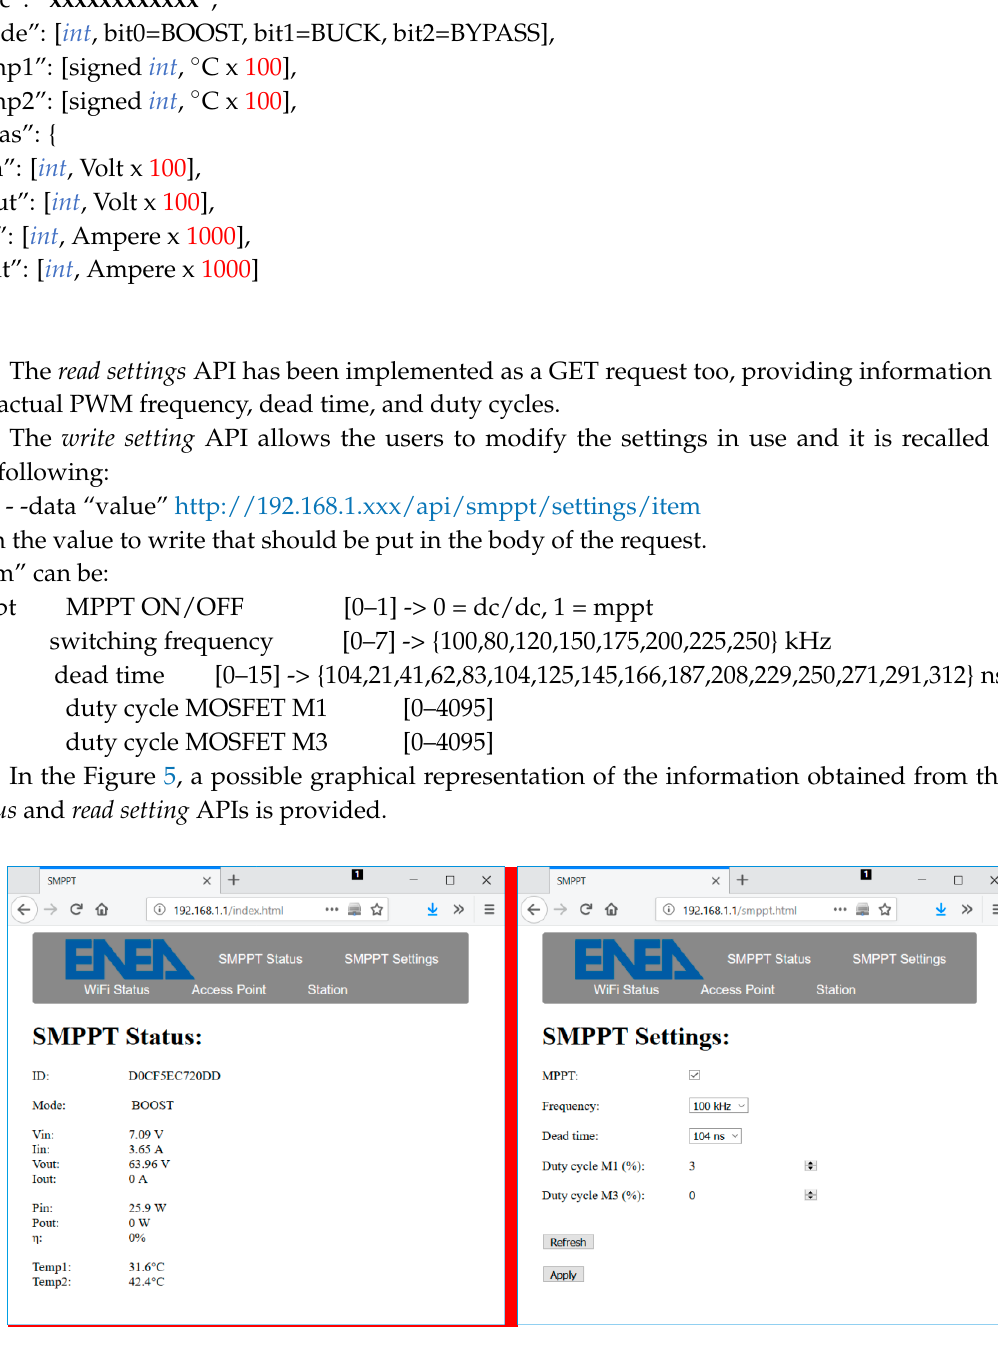
Figure 5. Dashboard examples.